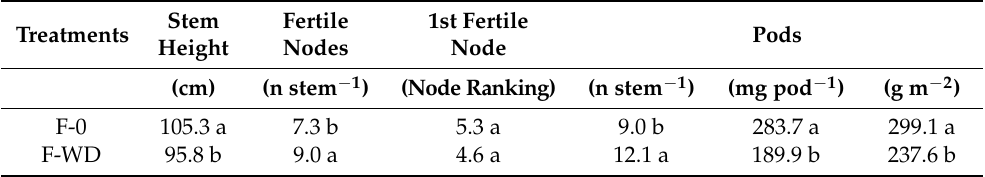
Table 6. Biometric and reproductive traits of field-bean stems as affected by the application of wood distillate (WD) as foliar spray. Data are means of two soil treatments and three replicates ( n = 6). For each parameter, means followed by the same letter are not significantly different at p ≤ 0.05, Tukey test.